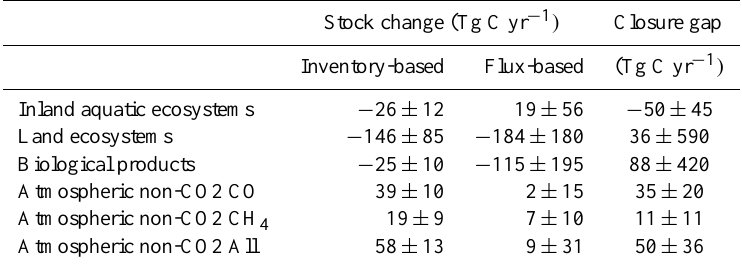
Table 3. Estimates of C-sinks based on inventory-based stock changes and indirect calculation of stock changes from associated flux esti- mates. The difference between both estimates is the closure gap and was used as a proxy for the internal consistency of the CO 2 , CO and CH 4 fluxes between 2001–2005. Calculation details are given in the text (Eqs. 3 to